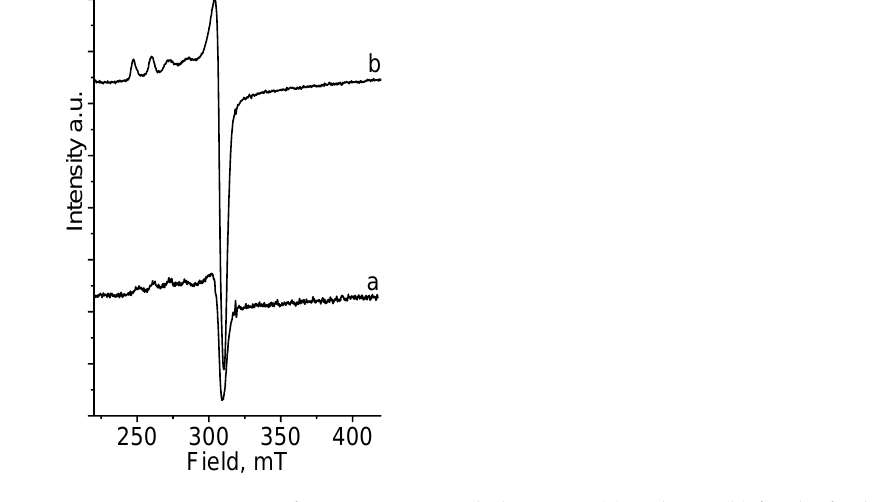
Figure 3. EPR spectra of Cu-SBA-15 recorded at 293 K (a) and 77 K (b) for the fresh sample. Interestingly, in this study, the evacuation of Cu-SBA-15 at 623 K in a vacuum (4 × 10 − 3 mbar) caused a significant reduction in the intensity of the EPR signal origi- nating from the paramagnetic copper complex (Figure 4). The EPR signal from copper in the octahedral environment disappeared completely. There was also a sharp peak at g = 1.998 with width ∆ Hpp = 1.1 mT, which can be attributed to the organic radical derived from residuals of the template used in the synthesis of SBA-15. In the parallel region, after evacuation at 623 K, hfs is poorly resolved and the intensity of the EPR signal is much weaker, similar as in the perpendicular region.